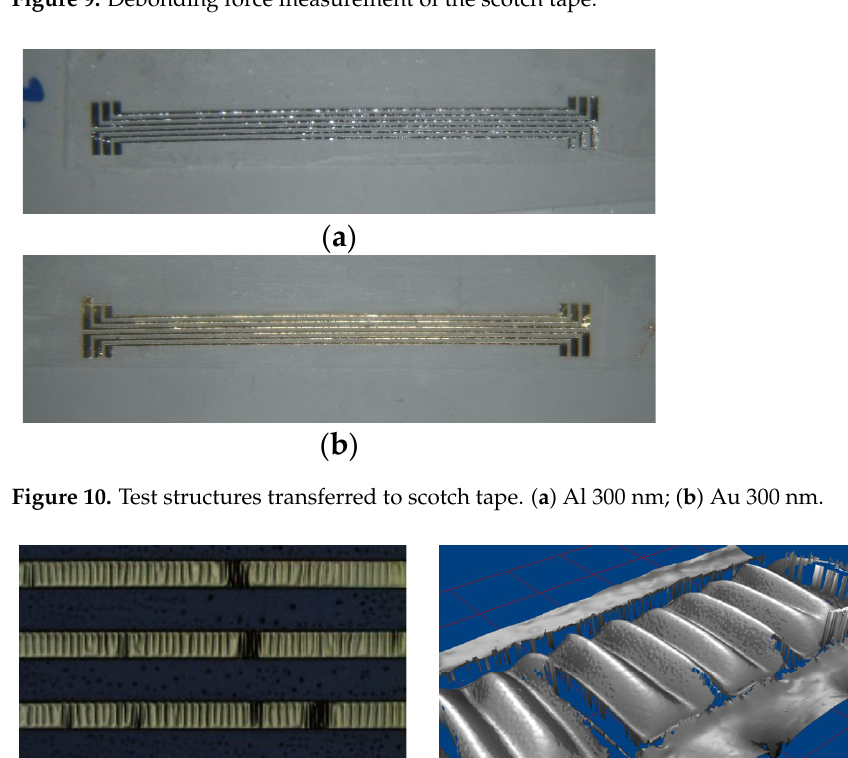
Figure 10. Test structures transferred to scotch tape. ( a ) Al 300 nm; ( b ) Au 300 nm.